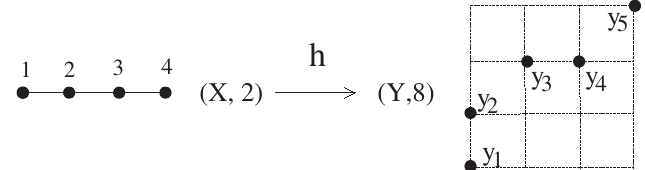
8 -isomorphism, where X : = { x i | i ∈ [ 0, 6 ] Z } ⊂ Z 2 and x 0 = ( 0, 0 ) , x 1 = ( 1, 1 ) , x 2 = ( 2, 0 ) , x 3 = ( 3, 1 ) , x = ( 4, 0 ) , x = ( 5, 1 ) , x = ( 4, 0 ) . Indeed, we may call the set ( X , 8 ) a finite fence set with 5 6 4 8 -adjacency.